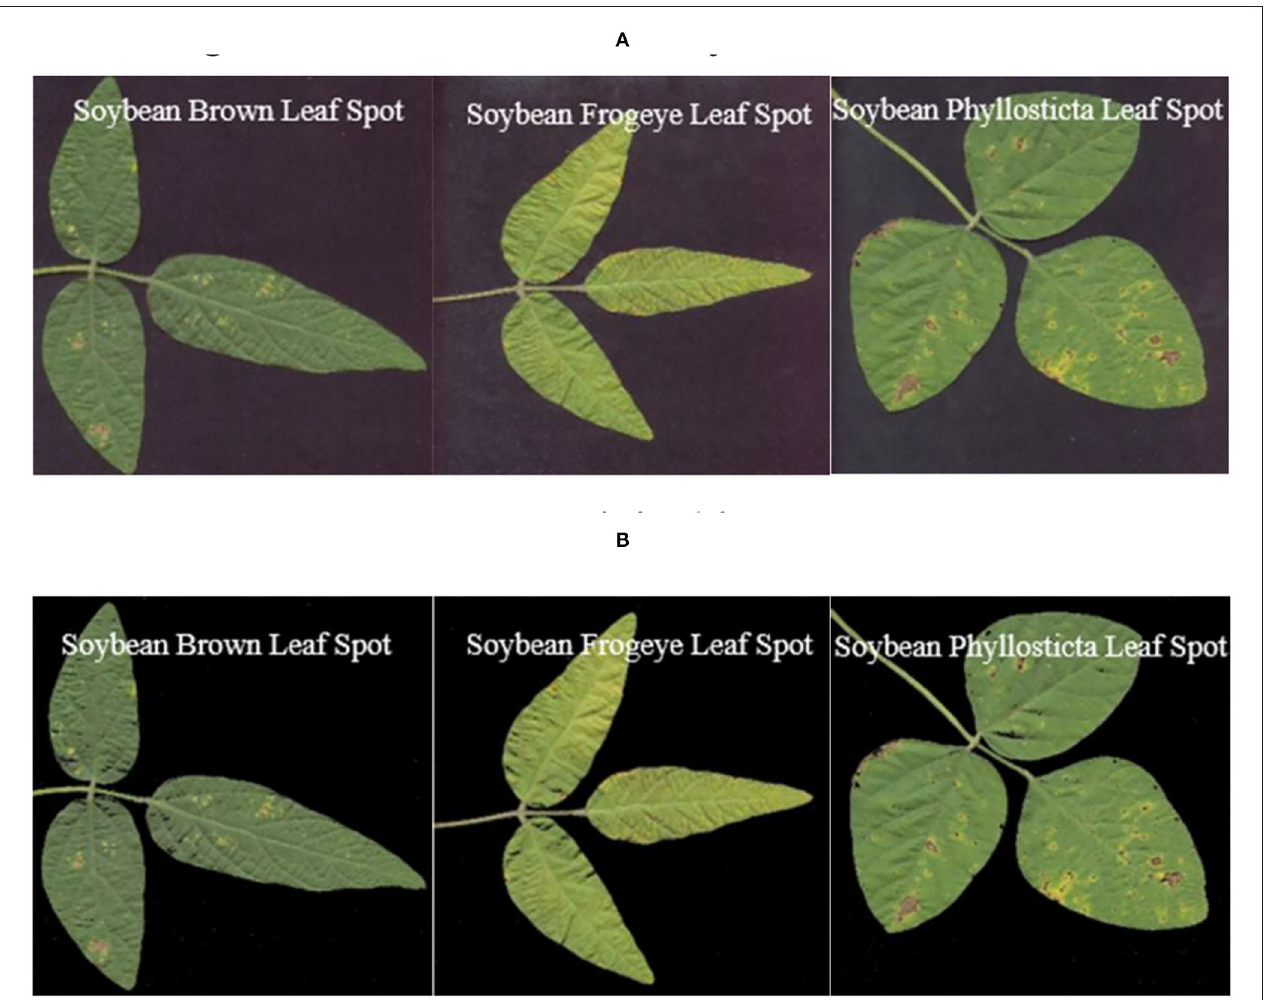
FIGURE 5 | Segmentation of soybean diseased leaves’ images with the OTSU algorithm. (A) Original images. (B) Segmented